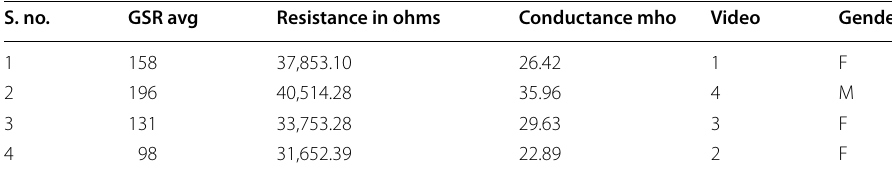
Table 4 Readings of the GSR Method for video induction method